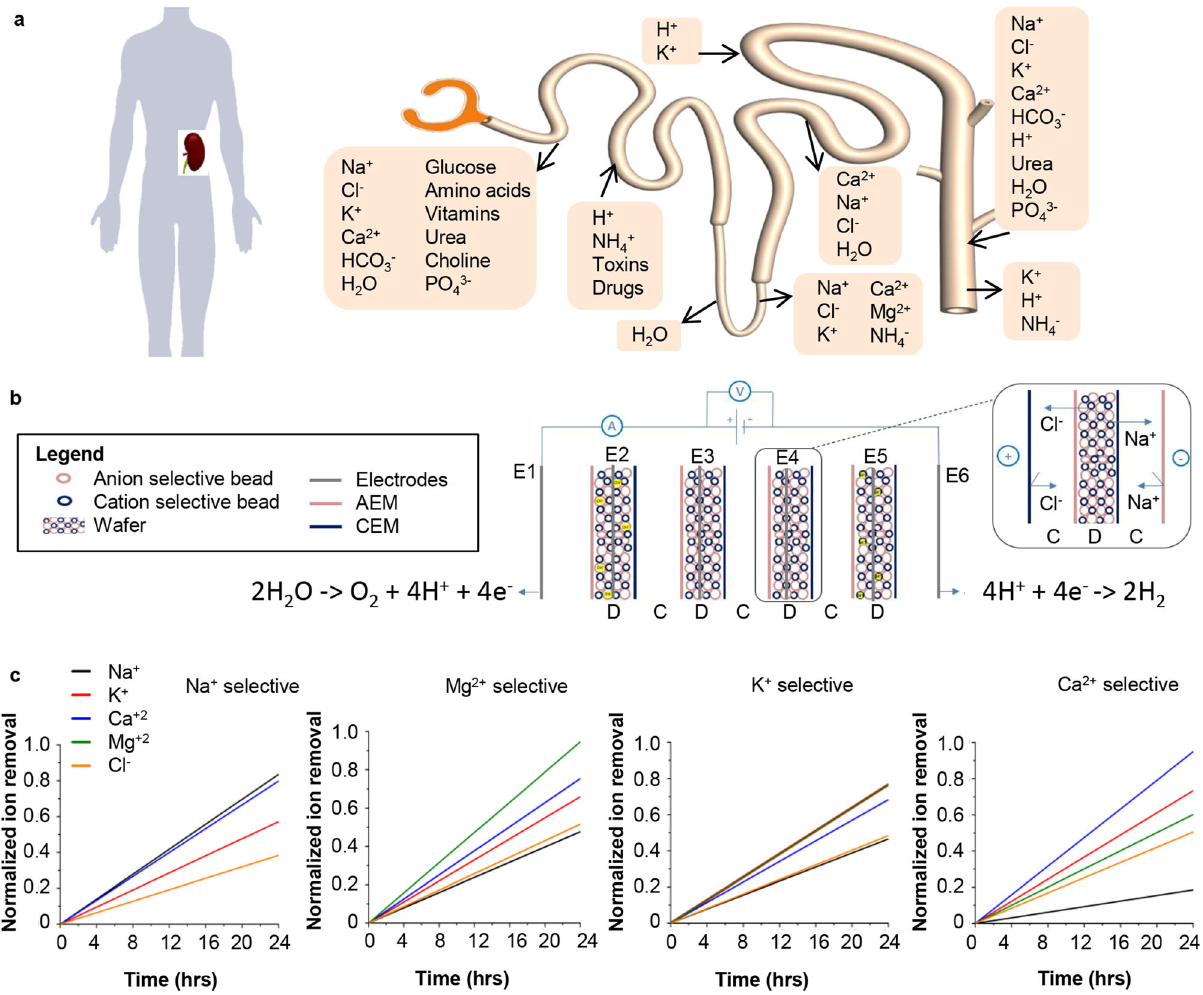
Fig. 1 Design and working principle of the activated wafer electrodeionization (AWEDI) for nephron simulation. a Transport processes in the nephron, b schematic of AWEDI wafer system, where C is concentrate stream, D is dilute stream, E1 – E6 represent the six different electrodes for controlling ion selectivity, c data for different AWEDI wafers demonstrating high selectivity for different cations (sodium, potassium, calcium, and